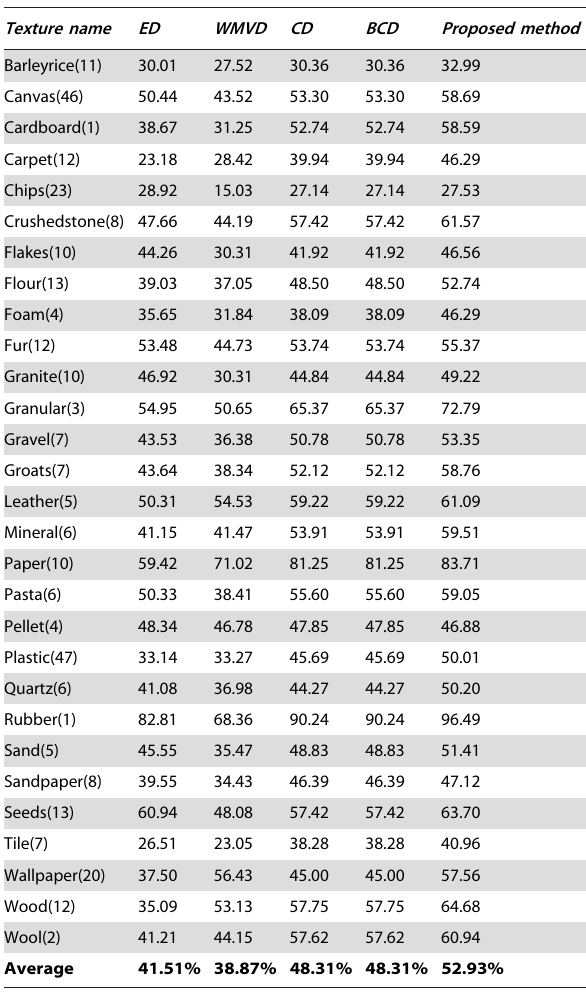
Table 6. Comparison of retrieval performance of different types of metrics for texture image retrieval using DT-CWT on the Outex image database (5104 images of 319 different